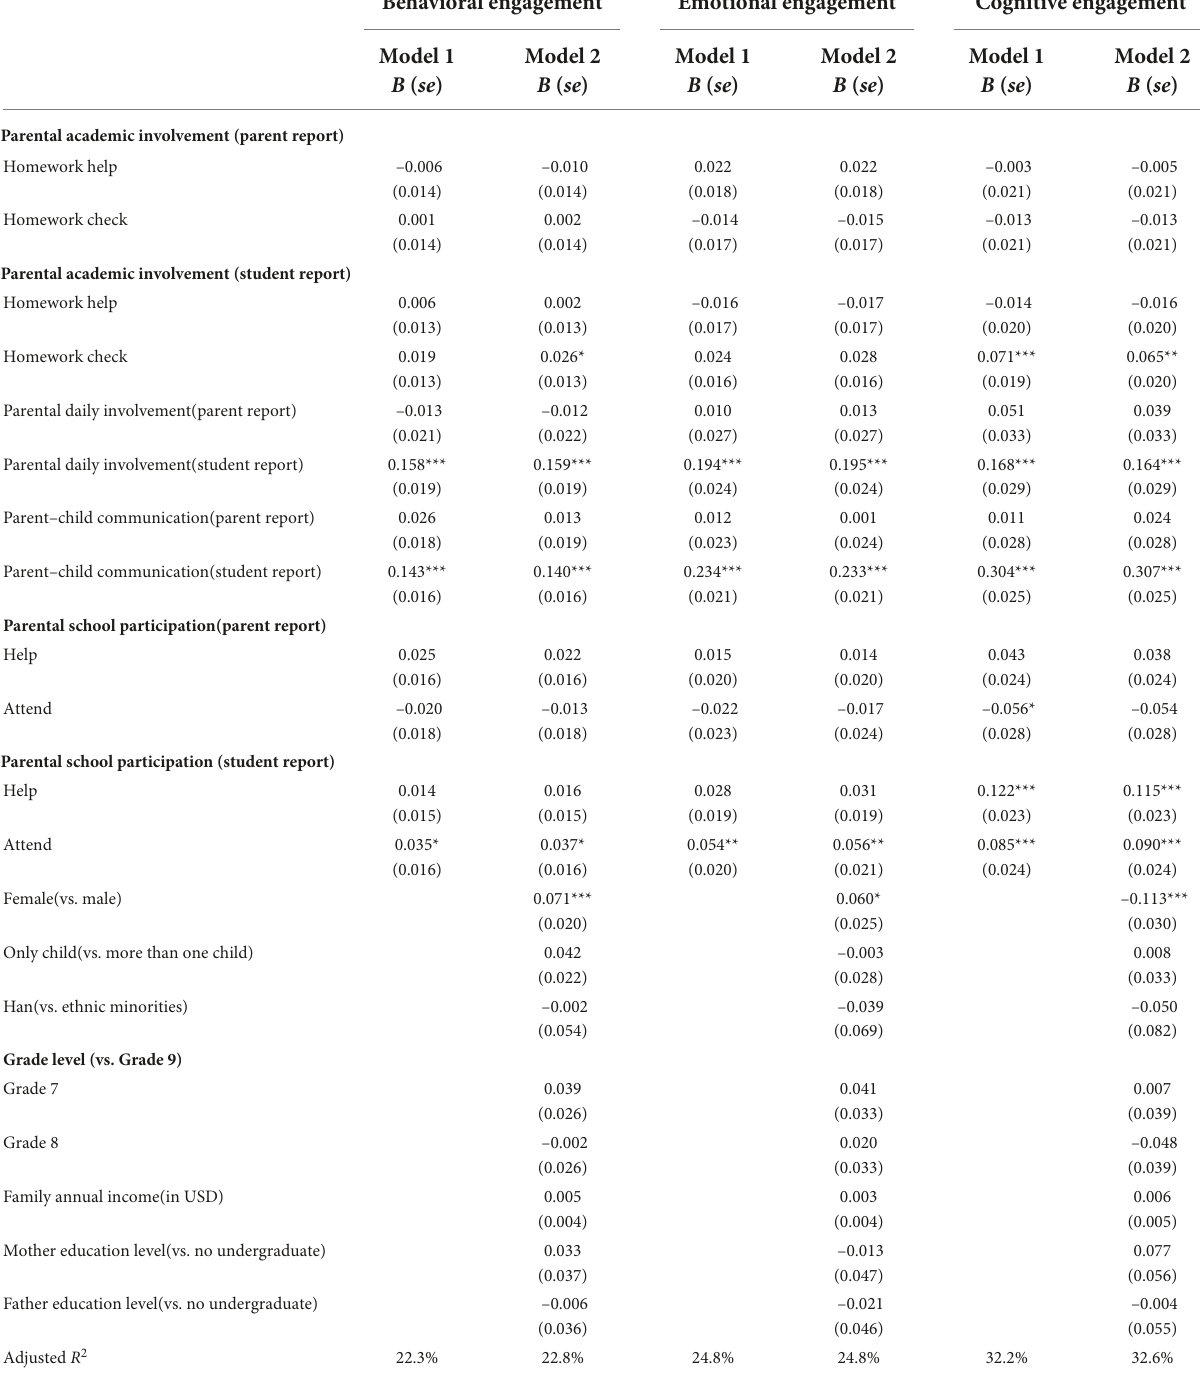
TABLE 4 Stepwise multiple linear regressions with school fixed